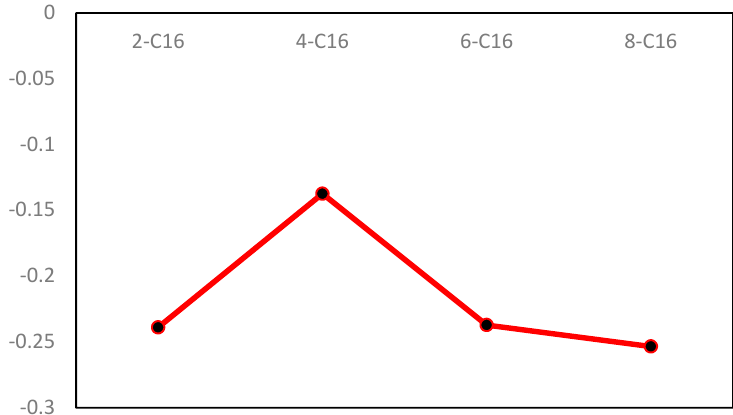
Figure 14. Hydrophobic tail chain order parameter.